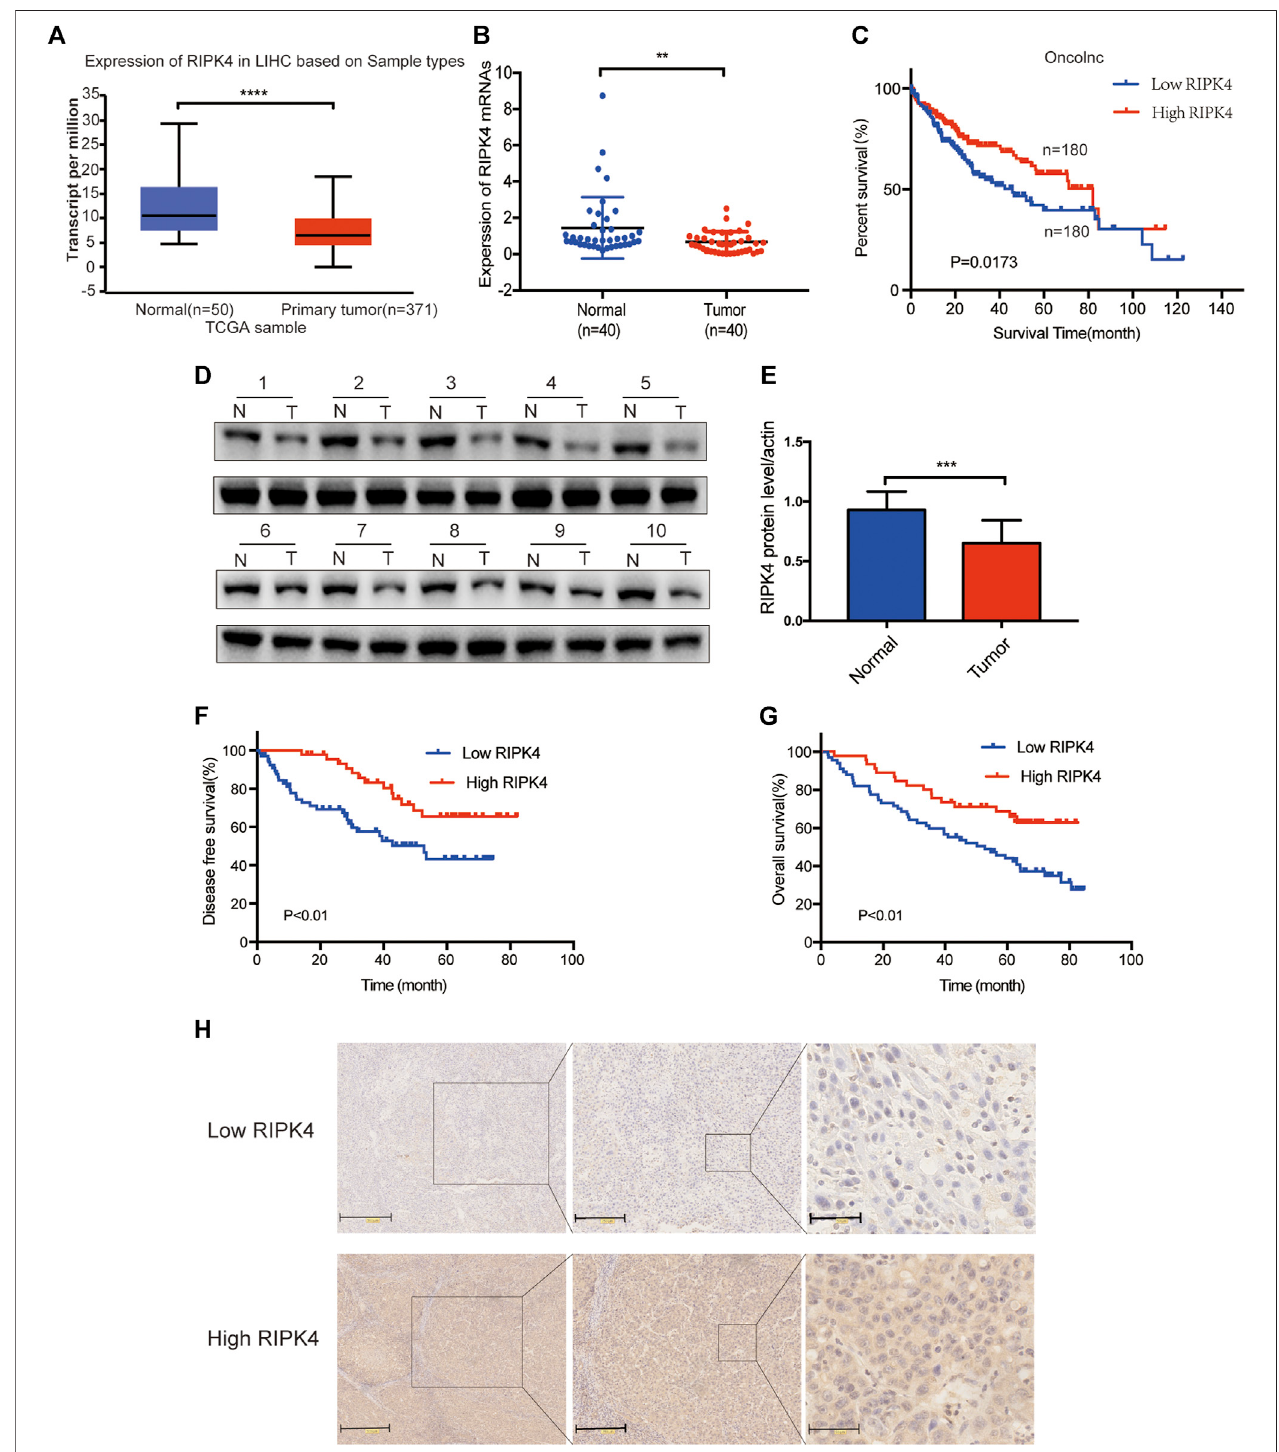
FIGURE 1 | The expression of RIPK4 is reduced in HCC and is associated with poor prognosis. (A) We used ualcan data to analyze the expression level of RIPK4 mRNAinHCCandnormaltissues. (B) Real-timequantitativePCRwasusedtoanalyzetheexpressionlevelsofRIPK4mRNAinthetumortissuesandadjacenttissuesof 40 patients with HCC. (C) Correlation between RIPK4 mRNA expression of oncolnc database and overall survival in patients with HCC ( n (cid:2) 360). (D) Western blot of RIPK4expressionintumortissuesandnormallivertissues. (E) RIPK4expressionlevelswerenormalizedaccordingto ß -actinexpressionlevels. (F/G) Kaplan-Meier plots of OS and DFS in HCC patients with higher and lower RIPK4 expression levels. (H) Representative images of RIPK4 immunohistochemical staining in HCC and normal liver tissue. ** p < 0.01; *** p < 0.001; **** p < 0.0001.